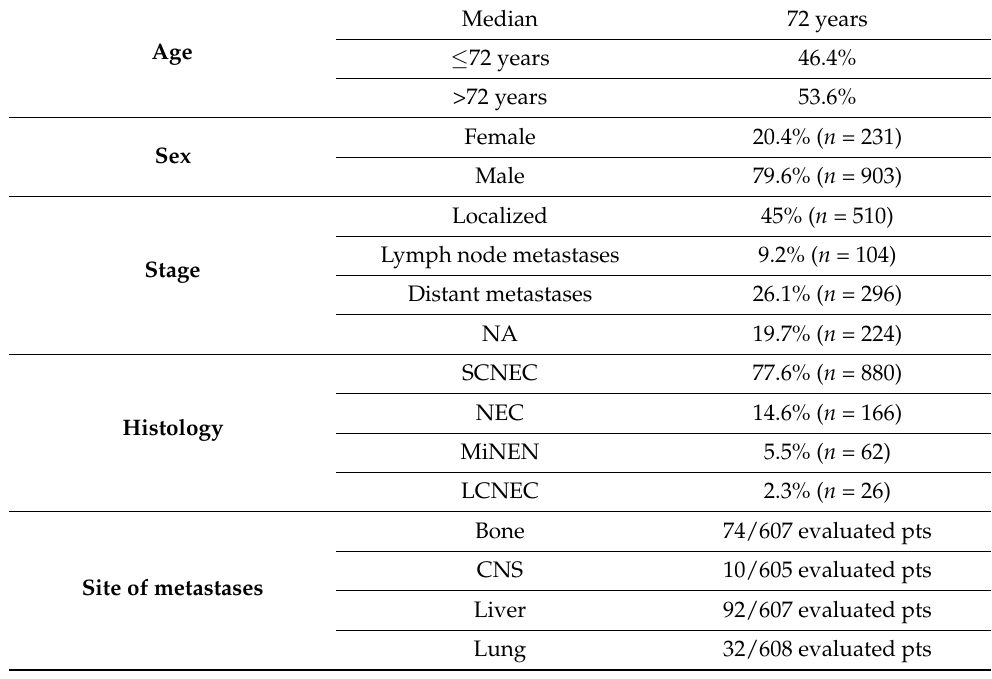
Table 1. Patient